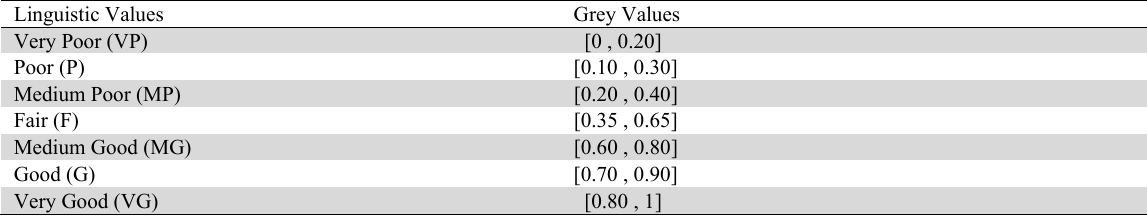
Linguistic terms and an their Grey Values Linguistic